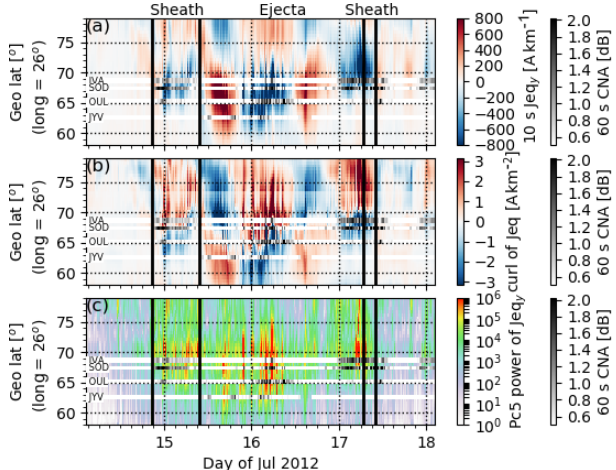
Figure 2. (a) Geographic latitude profiles of the auroral ionosphere eastward electrojet current density (Jeq y ) at 26 ◦ E, derived from 10s IMAGE magnetometer measurements, (b) curl of the equiv- alent current density as a proxy for field-aligned current density (positive downward), and (c) Pc5 pulsation power, estimated by in- tegrating Jeq y wavelet power over the Pc5 period range. All panels include 60s cosmic noise absorption (CNA) as a function of UT, derived from IVA, SOD, OUL, and JYV riometer measurements. CNA can be used as an indicator of energetic-electron ( > 30keV) precipitation. Time is given in MLT at the geomagnetic longitude of the riometer stations (here MLT ≈ UT +